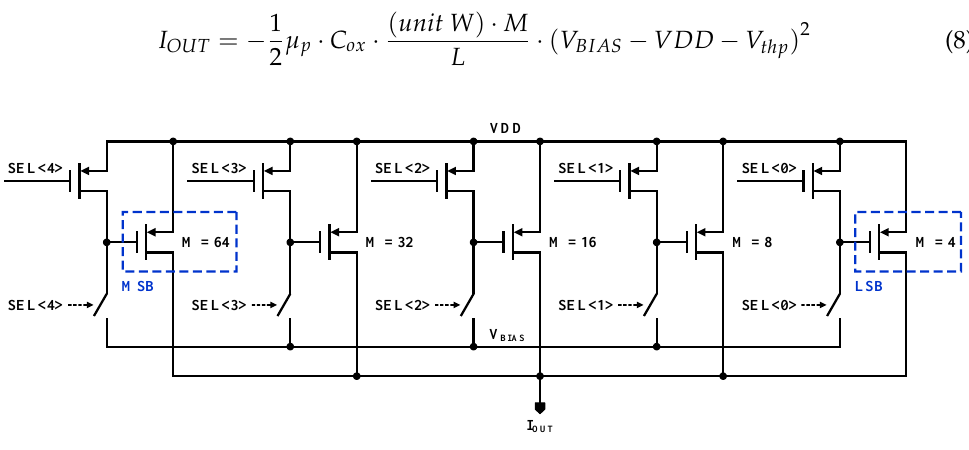
Figure 5. Schematic of proposed 5-bit current generator.